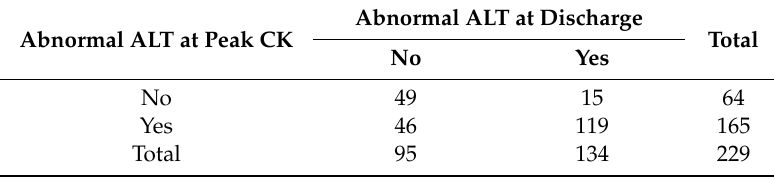
Table 3. Cross-tabulation of alanine aminotransferase (ALT) at peak CK and at time of discharge. Abnormal ALT at Peak CK